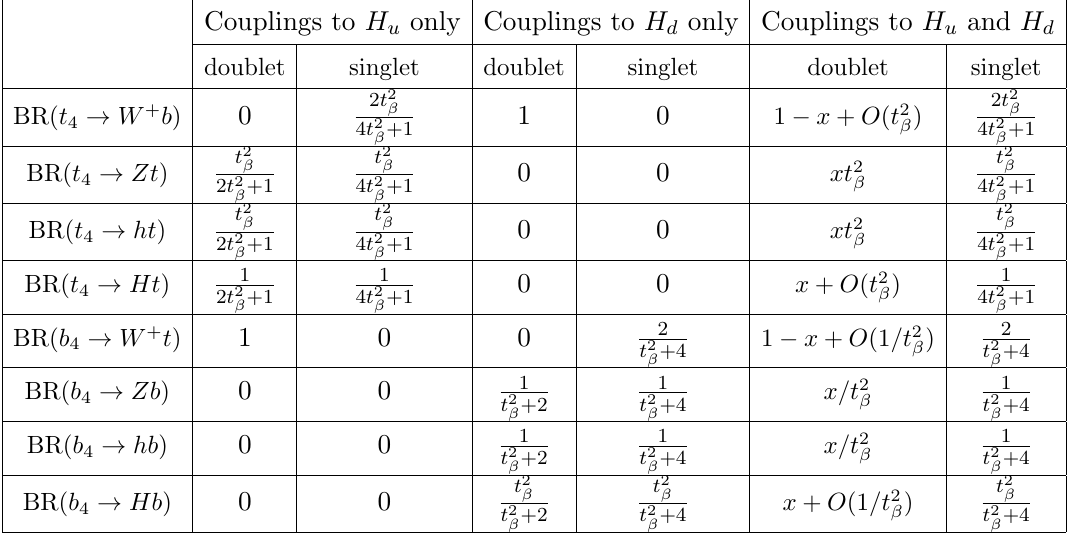
Table 4 . Branching ratios of the vectorlike quarks t 4 and b 4 into W , Z , h and H as a function of t (cid:12) = tan (cid:12) . These expressions are exact for heavy vectorlike masses and in the limit in which the couplings in table 2 dominate.